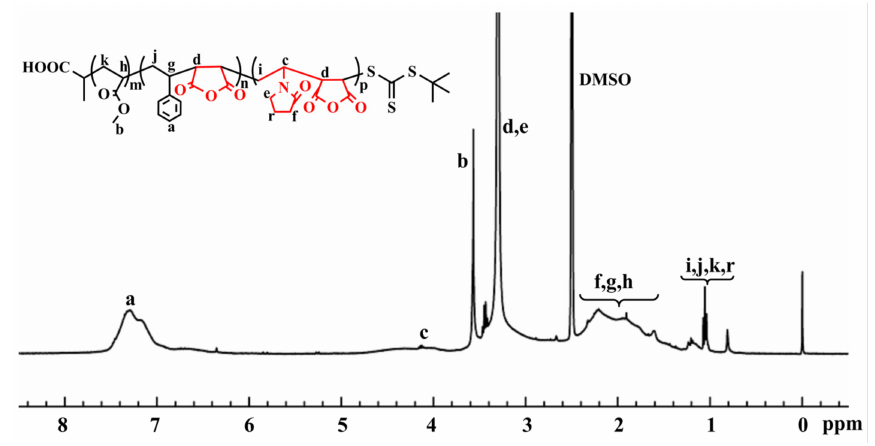
Figure 4. 1 H-NMR spectra of block polymer PMA- b -P